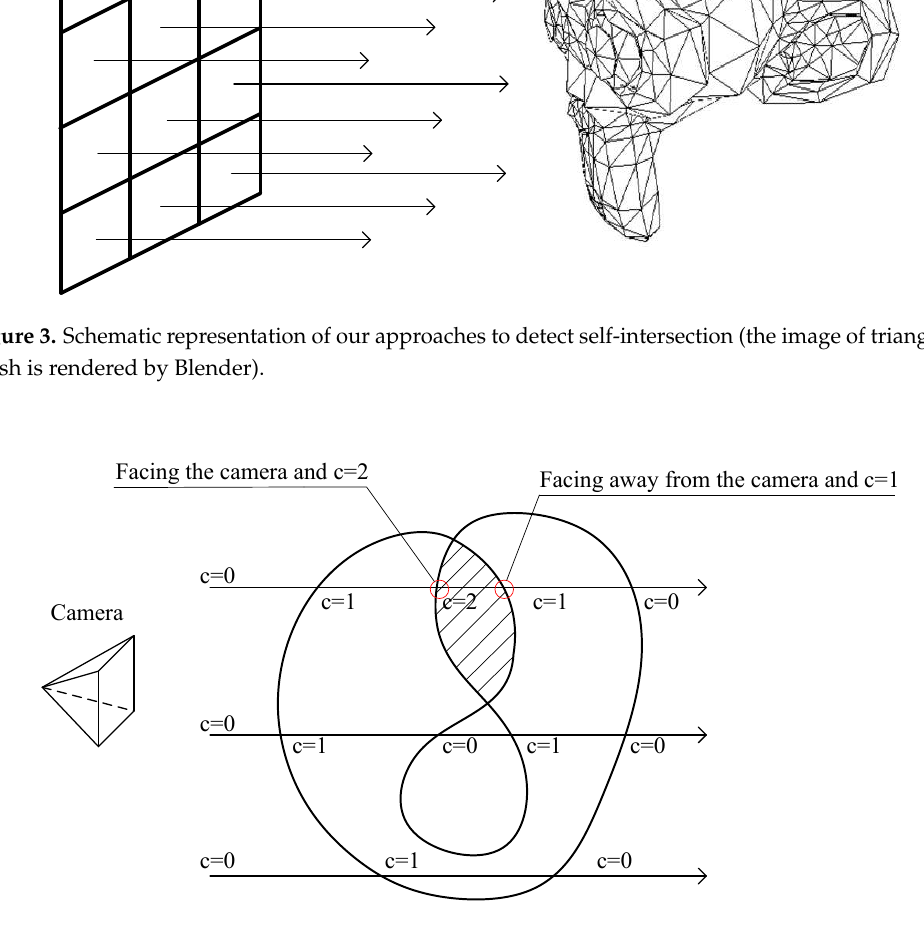
Figure 4. An intuitive representation of our algorithm to detect self-intersection. The detection rays are emitted from the camera, the dashed area represents the self-intersection region. The vertices in red circle were detected to be in self-intersection according to the counter and